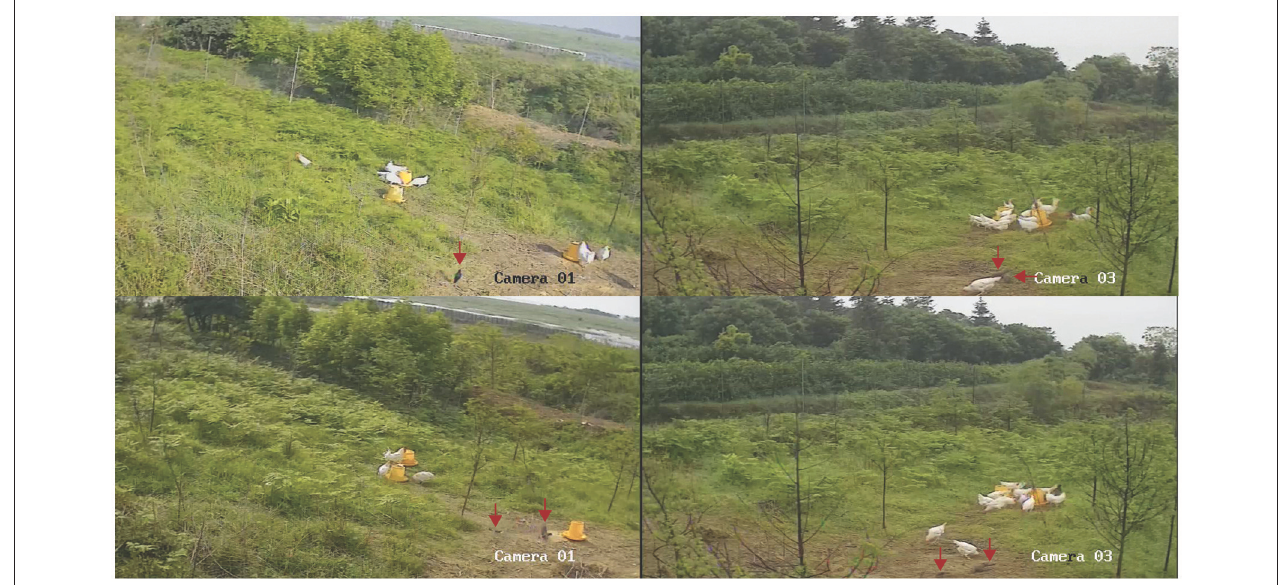
FIGURE 4 | Monitors captured partial image of birds during the surveillance period. Red arrows indicate observed birds in study site.